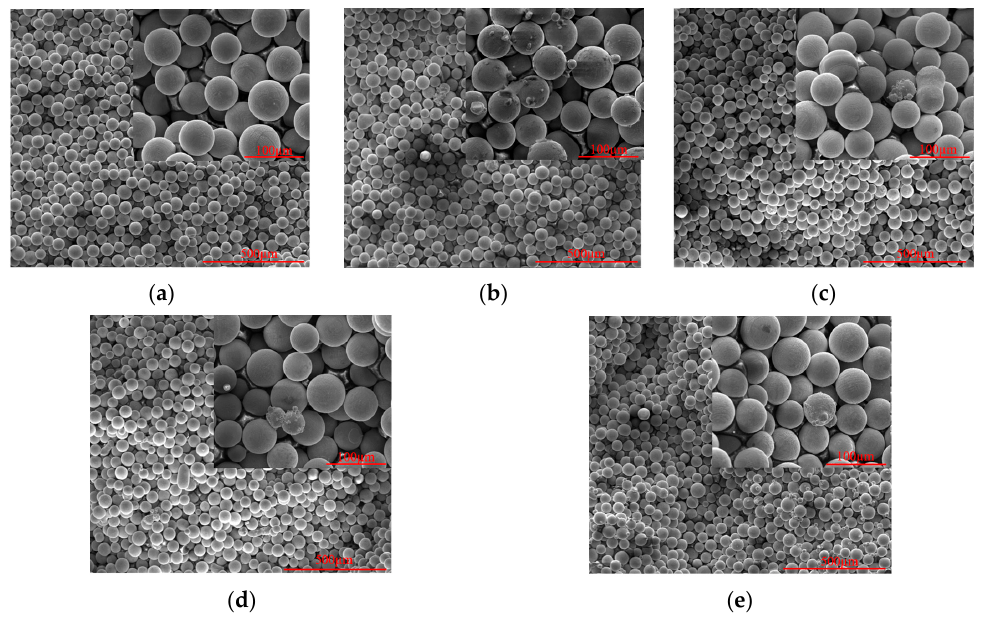
Figure 3. SEM morphology of the powder. ( a ) new powder; ( b ) one time recovery powder; ( c ) two times recovery powder; ( d ) three times recovery powder; ( e ) four times recovery powder.